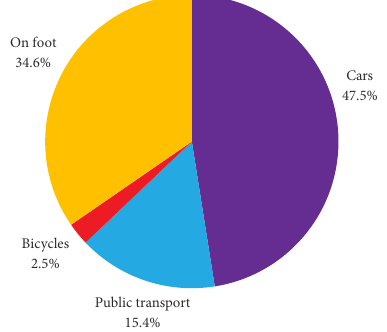
Figure 2. The modal split in Birštonas (LR AM